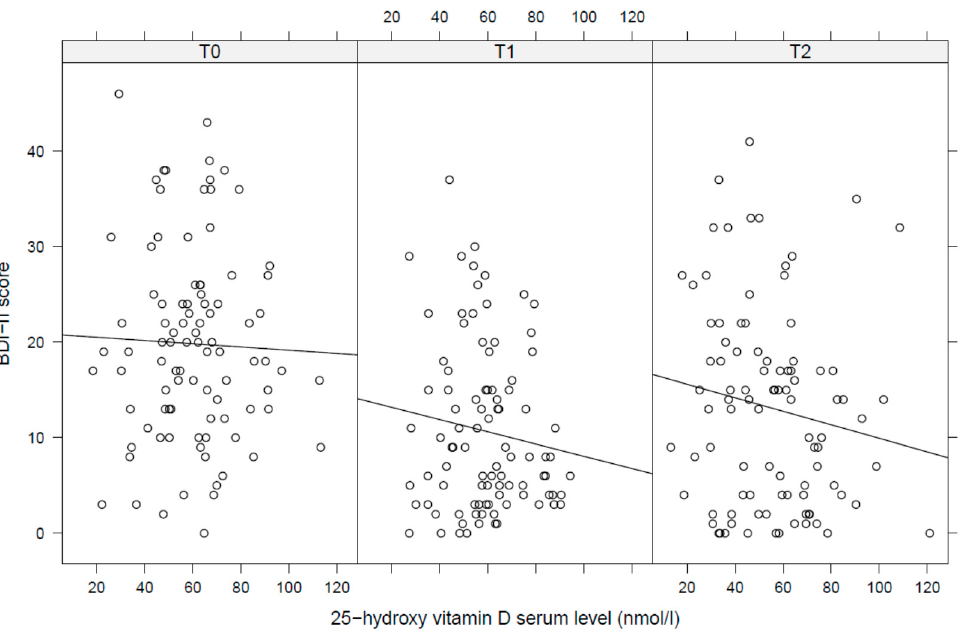
Figure 1. Pearson correlations between 25-hydroxy vitamin D serum levels and depressive symptoms (T0 = admission, T1 = discharge, T2 = 1 year follow up). BDI = Beck Depression Inventory, 25(OH)D = 25-hydroxy vitamin D serum level. Table 2. Results from mixed linear models on cross-sectional, prospective, and longitudinal associ- ations between serum 25(OH) vitamin D levels and depressive symptoms. Outcome: BDI-II Score at Each Measuring Time Point (T0, T1, T2) ß